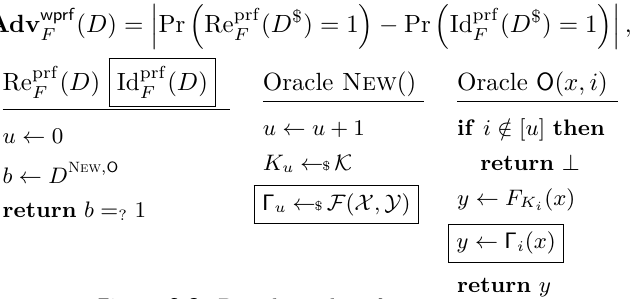
Figure 2.3: Pseudorandom function